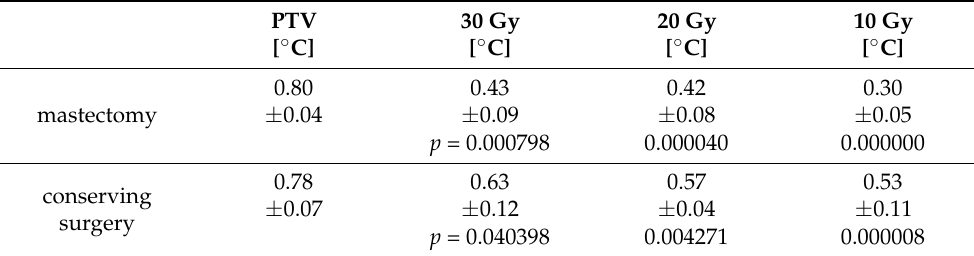
Table 2. Temperature increase for the PTV area, 30 Gy, 20 Gy, and 10 Gy in the third week of treatment in two study